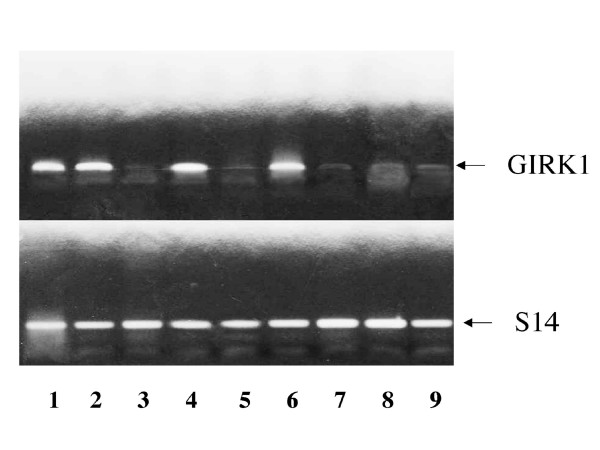
Agarose gel electrophoresis of RT-PCR amplified 230 bp GIRK1 cDNA, and 143 bp S14 DNA as internal PCR control. Lane 1, size marker; Lane 2, human pulmonary adenocarcinoma cell line PC-14 (positive control); Lane 3, pulmonary adenocarcinoma with high GIRK1 expression. Lane 4, pulmonary adenocarcinoma with low GIRK1 expression. Lane 5, squamous cell carcinoma with high GIRK1 expression. Lane 6, squamous carcinoma with low GIRK1 expression. Lane 7, large cell carcinoma with high GIRK1 expression. Lane 8, large cell carcinoma with low GIRK1 expression. Lane 9, and Lane 10, normal pulmonary tissue with low GIRK1 expression.